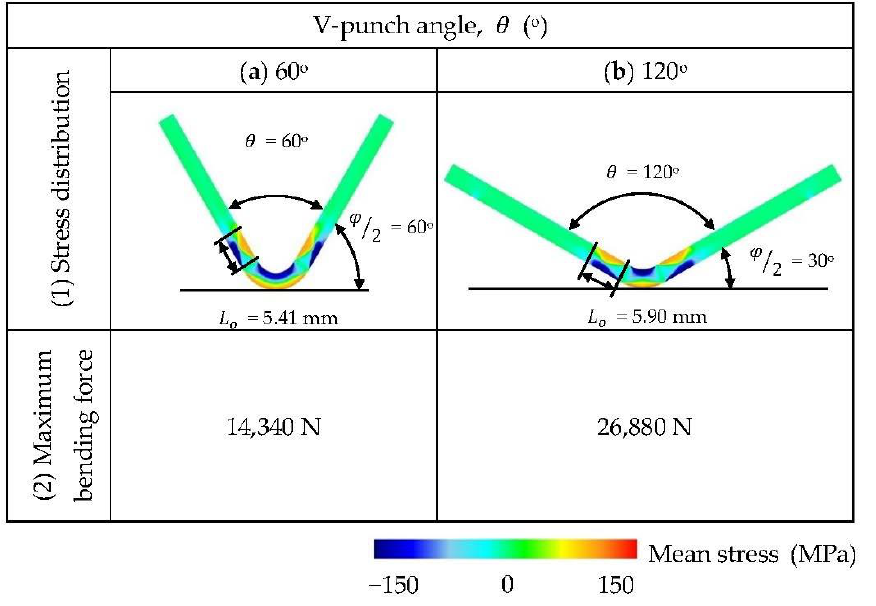
Figure 10. Illustration of mean stress and bending force with respect to bend angles. ( 𝑅 𝑝 = 3.5 mm, 𝑇 = 3 mm, AA1100-O, 𝐿 = 70 mm, l k = 60 mm).